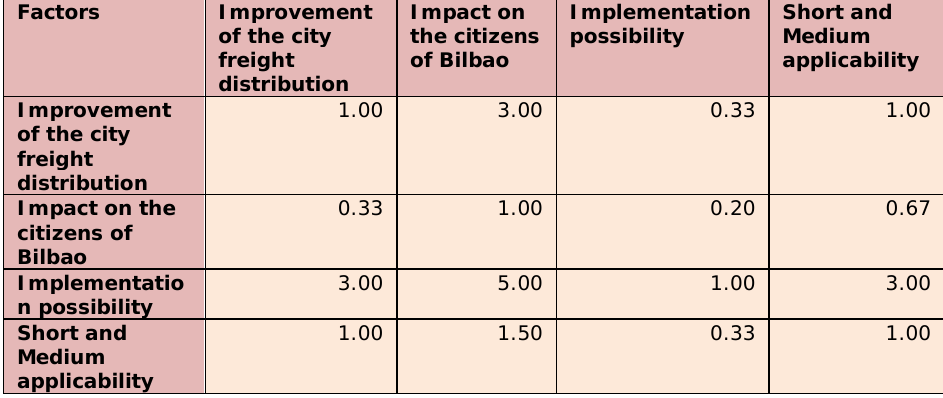
Table 1. Peer comparison between the selected